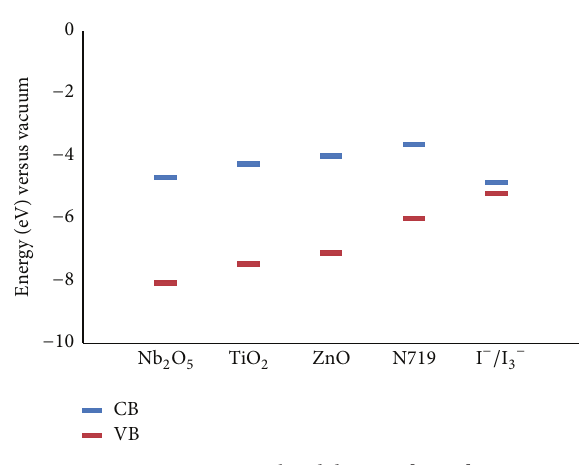
Figure 3: Energy band diagram [21,